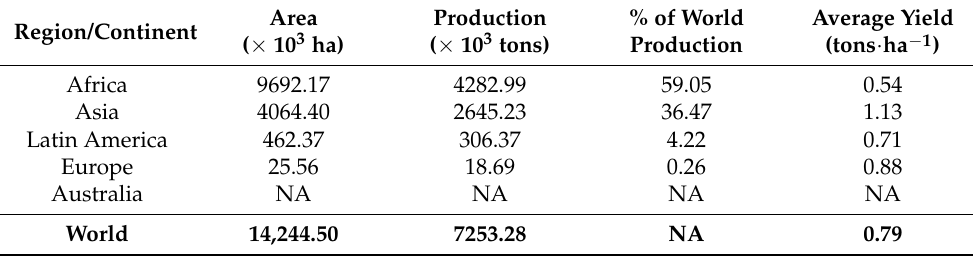
Table 1. Regions of global sesame production in 2020. Region/Continent